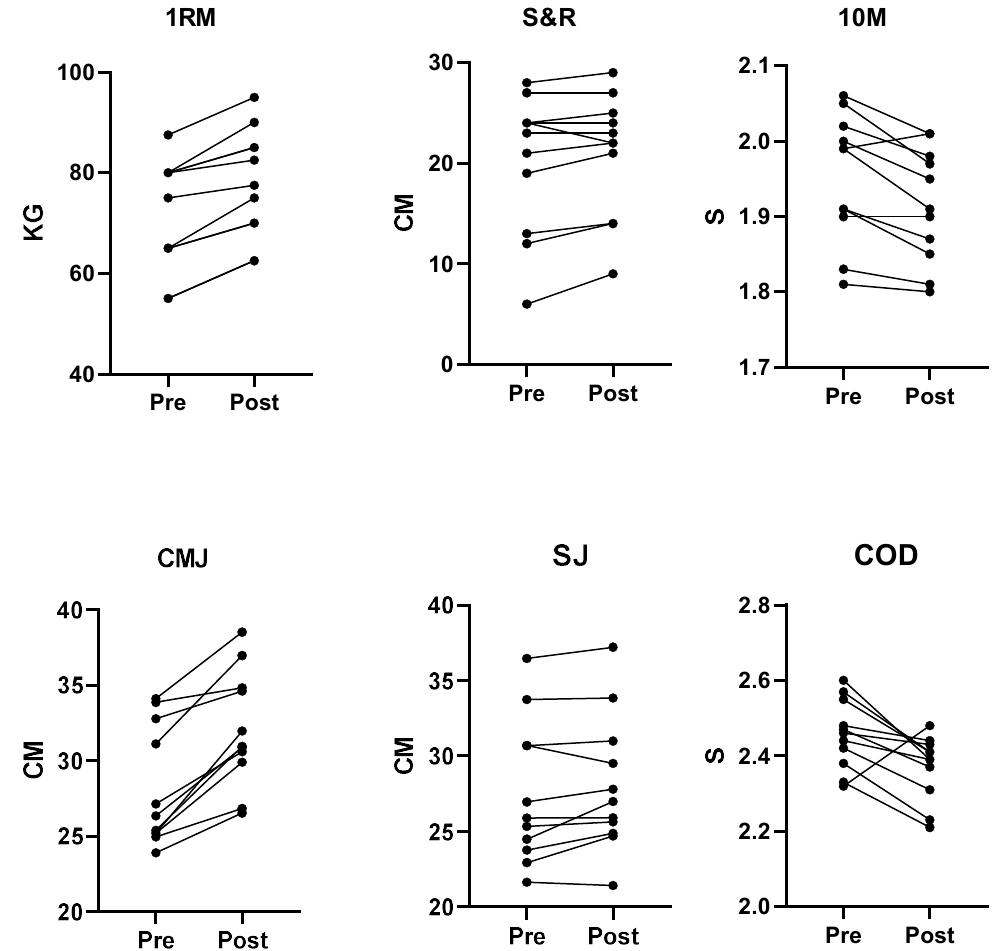
Figure 1. Pre and post intervention data for FIT group. Abbreviations: 1RM; 1 rep maximum squat test, S&R; sit and reach test, 10 M; 10 metre sprint test, CMJ; counter-movement jump, SJ; squat jump, COD; 505 change of direction test.